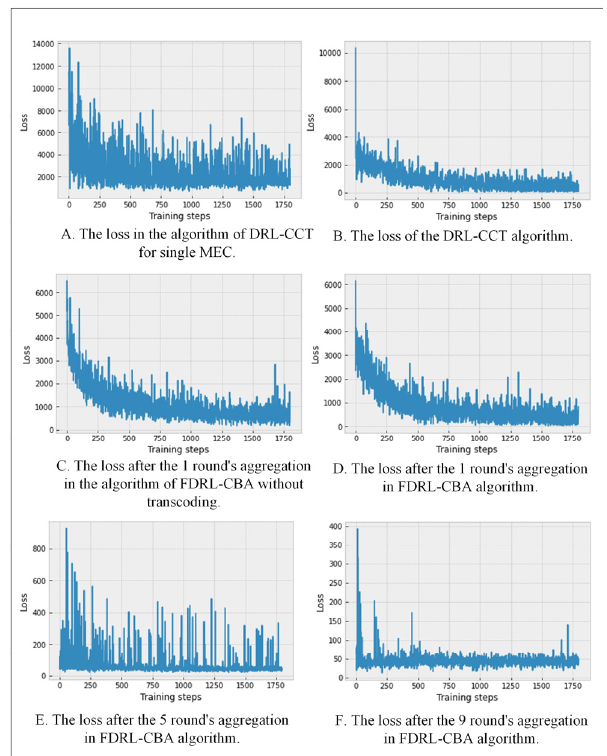
Figure 4. Comparison of the loss performance.